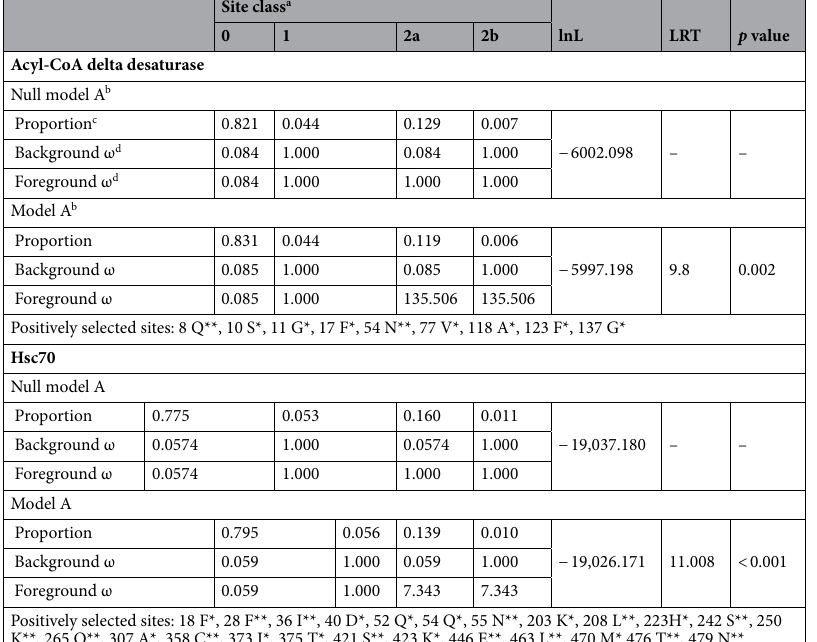
The major biological processes identified in a GO enrichment analysis of the rapidly evolving gene families in P. steinenii (i.e., defense response to Gram-positive bacterium, mRNA cleavage, and DNA packaging; Fig. 2a) provide insight into the mechanisms underlying survival in cold environments. Among rapidly evolving gene families in the P. steinenii genome, several serine protease-related gene families (e.g., serine protease, serine pro- tease Persephone, serine protease trypsin, and venom serine protease) were involved in the defense response to